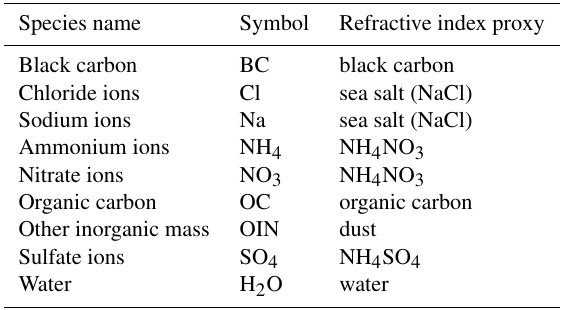
Table A1. MOSAIC aerosol species.